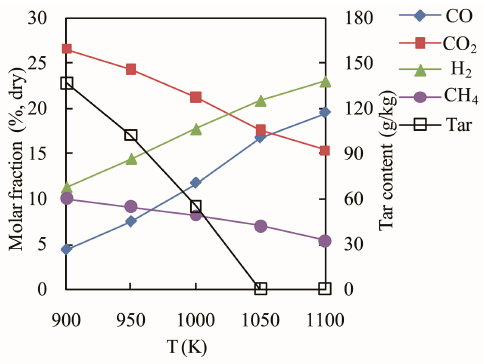
Figure 7. Effects of gasification temperature on syngas composition and tar content at ER = 0.2 and SBR = 0.3.